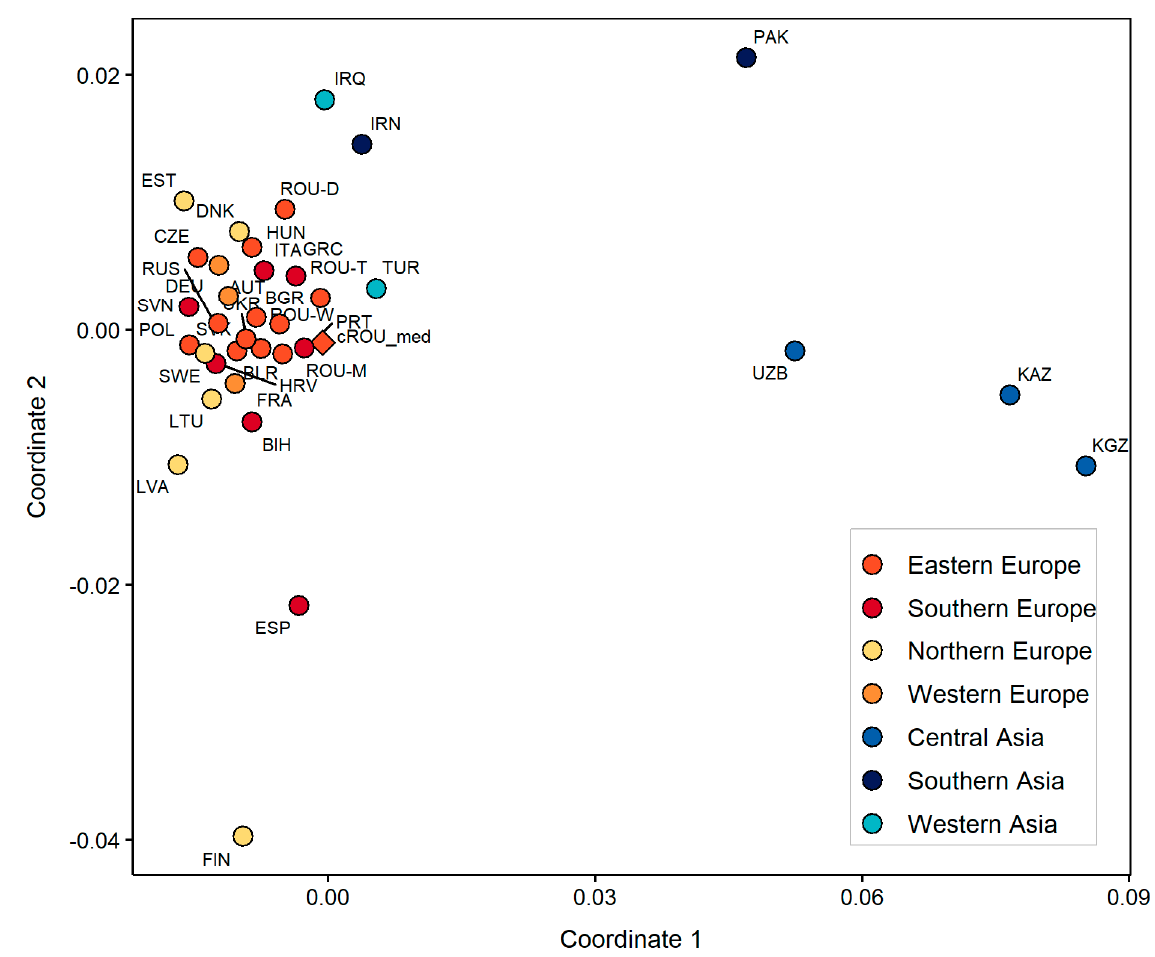
Figure 5. MDS plot of the investigated population (cROU_med) and modern Eurasian populations. The MDS plot was performed using linearized Slatkin Fst values, detailed in Table S6. Stress value is 0.1085145.